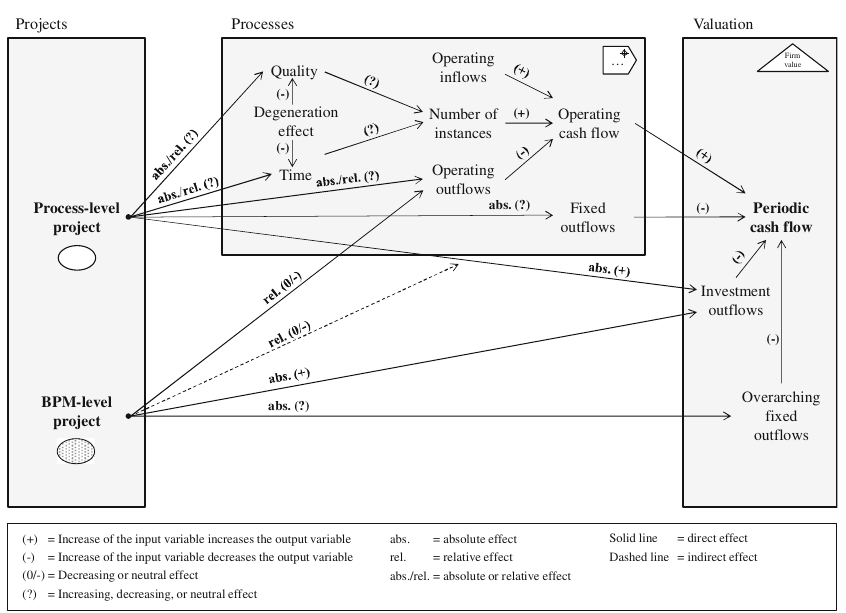
Fig. 2 Performance effects of process- and BPM-level projects (for a single period and